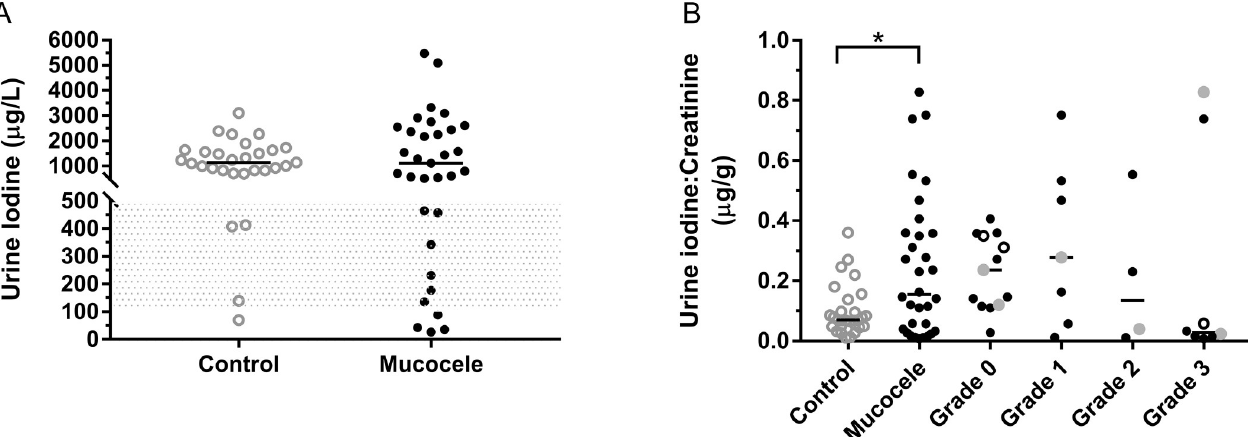
Fig 5. Urine iodine concentration (A) and urine iodine to creatinine ratio (UICR) (B) of control dogs and dogs diagnosed with gallbladder mucocele formation. Panel A demonstrates values for urine iodine concentration in individual dogs. Bar = median. Shaded area represents the NRC recommended daily intake of iodine (in μ g) as expressed on the basis of metabolic body weight. Panel B demonstrates UICR for both groups of dogs and in dogs with gallbladder mucocele formation as subdivided by illness severity score. Among dogs with gallbladder mucocele formation, filled gray data points represent dogs meeting proposed criteria for diagnosis of hypothyroidism. Open circle data points represent 3 dogs that were subsequently euthanized and had thyroid tissue obtained for iodine measurement. Bars = median. � p < 0.05 Kruskal Wallis One Way ANOVA on Ranks.